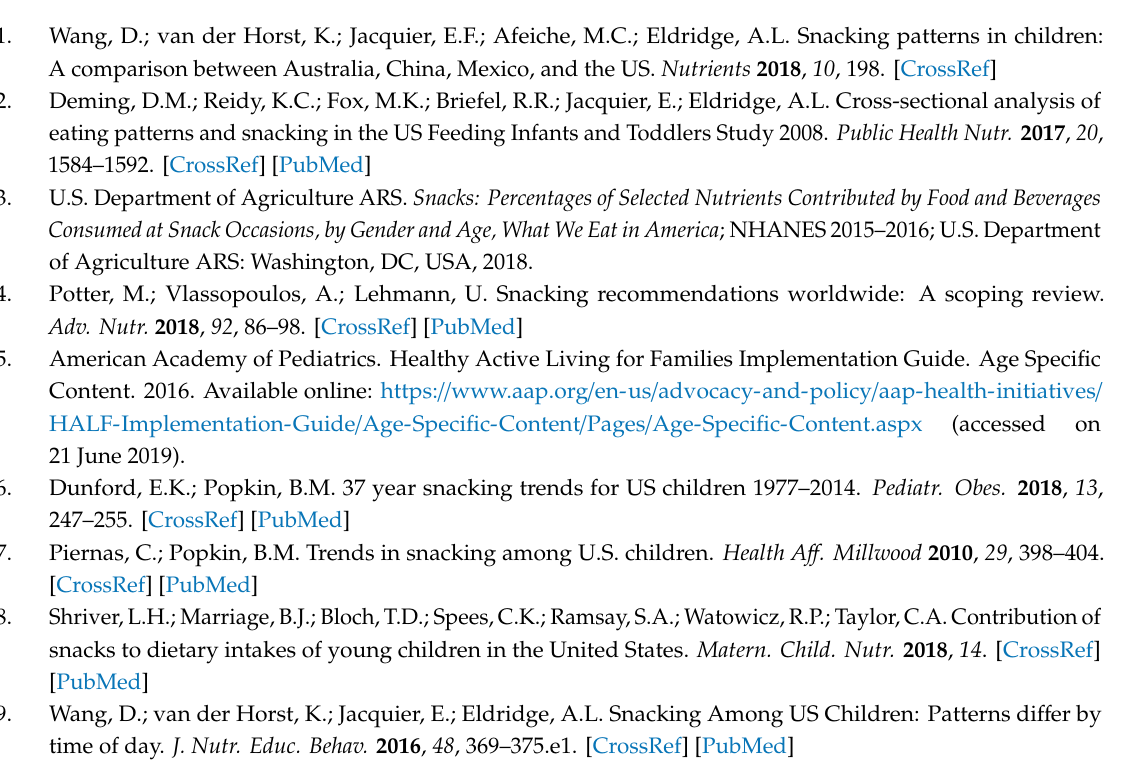
s1, Table S1. Associations of snacking parameters with HEI-2015 component scores among US children aged two to five years ( n = 3679), Table S2. Associations of snacking parameters with nutrient adequacy ratios for five shortfall nutrients among US children aged two to five years ( n = 3679), Table S3. Associations of snacking parameters with children’s % of recommended limits consumed from added sugar, saturated fat, and sodium among US children aged two to five years ( n =